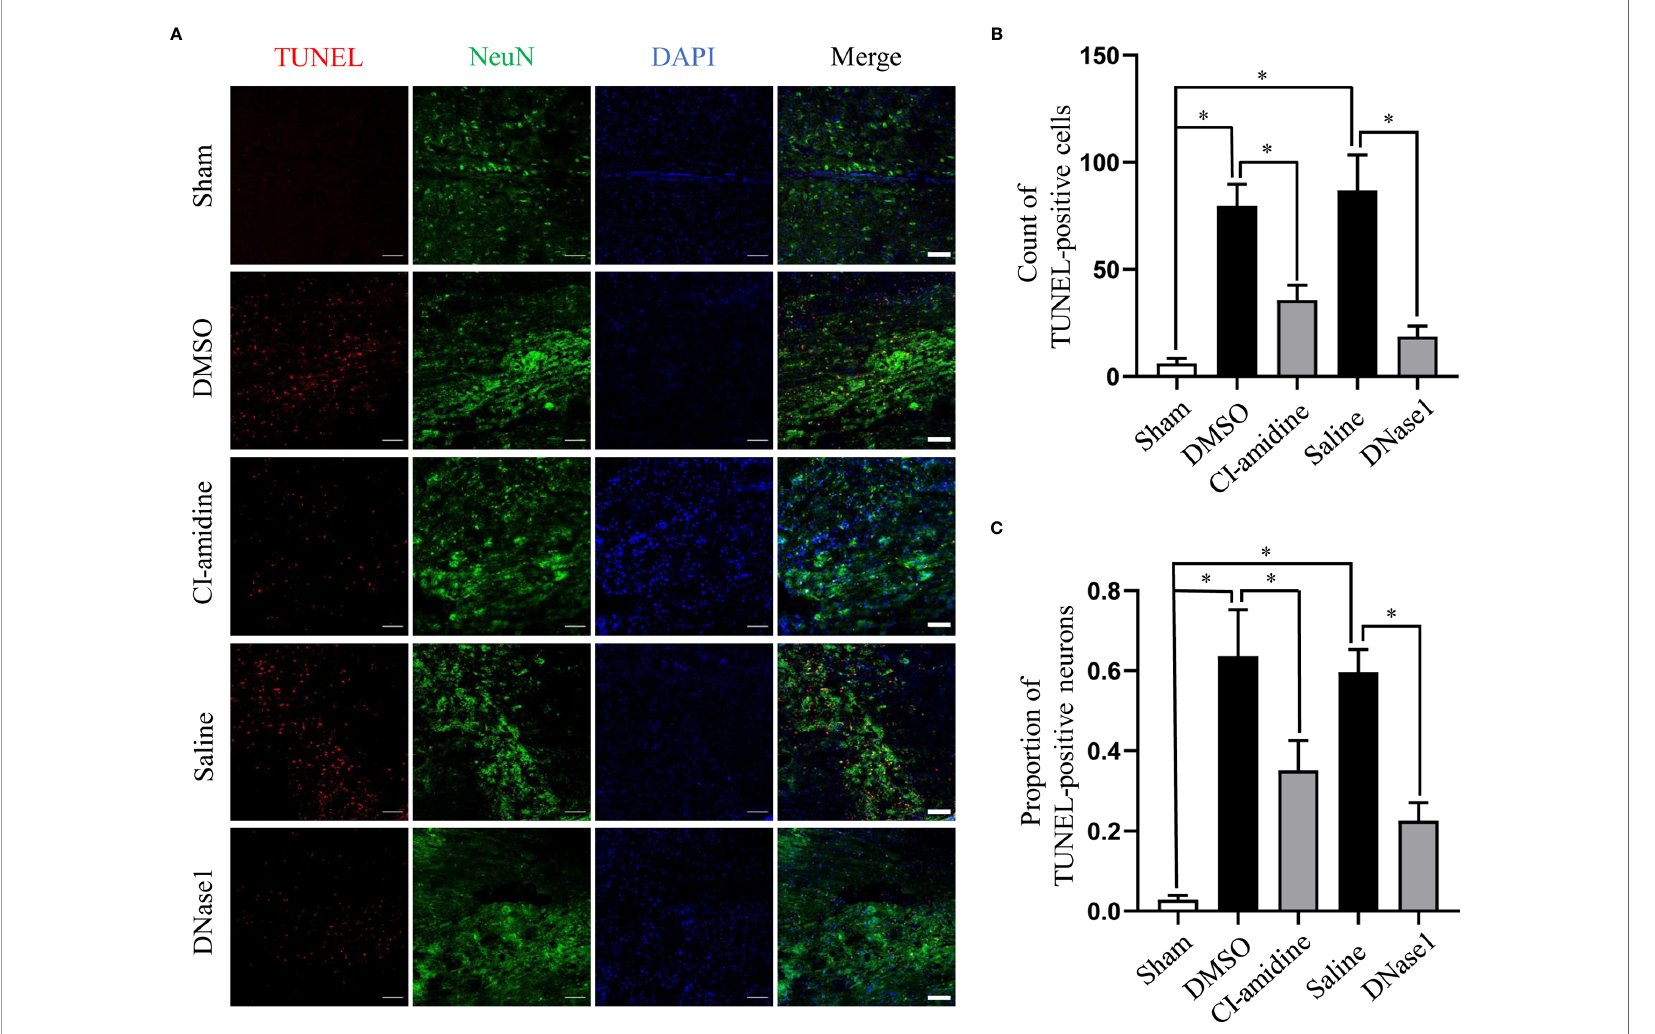
FIGURE 5 | Restricting NETs reduces cell death after SCI. (A) Representative images of TUNEL (red) and NeuN (green) double-positive cells in injured spinal cord of each group at 24 h after operation. Nuclear was marked with DAPI (blue). Scale bars = 100 m m. Quanti fi cation of (B) TUNEL-positive cells and (C) double-positive cells in injured spinal cord of each group at 24 h after SCI. Data are presented as means ± SD of n = 6 (* p <